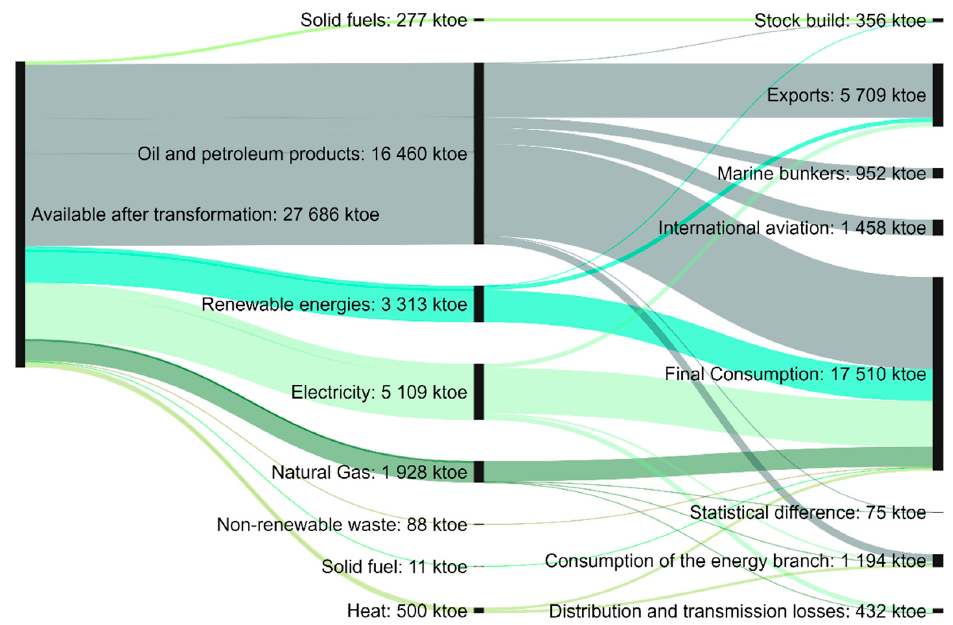
Figure 18. Portuguese energy balance flow concerning the destination of available energy after transformation–2019 data (adopted from Eurostat data).